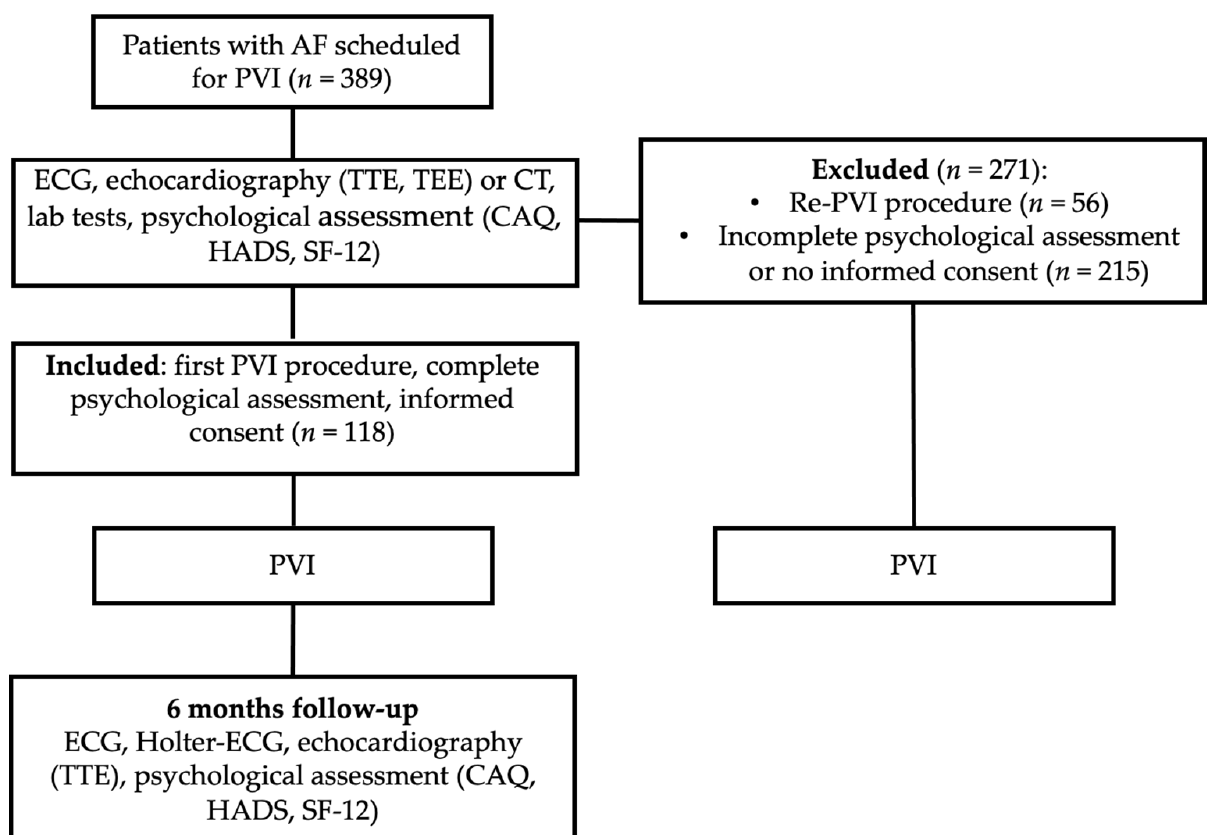
Figure 1. Study Flow Chart. AF = atrial fibrillation; PVI = pulmonary vein isolation; ECG = electrocardiogram; TTE = transthoracic echocardiography; TEE = transesophageal echocardiography, CT = computed tomography; CAQ = Cardiac Anxiety Questionnaire; HADS = Hospital Anxiety and Depression Scale; SF-12 = Short Form Health Survey.